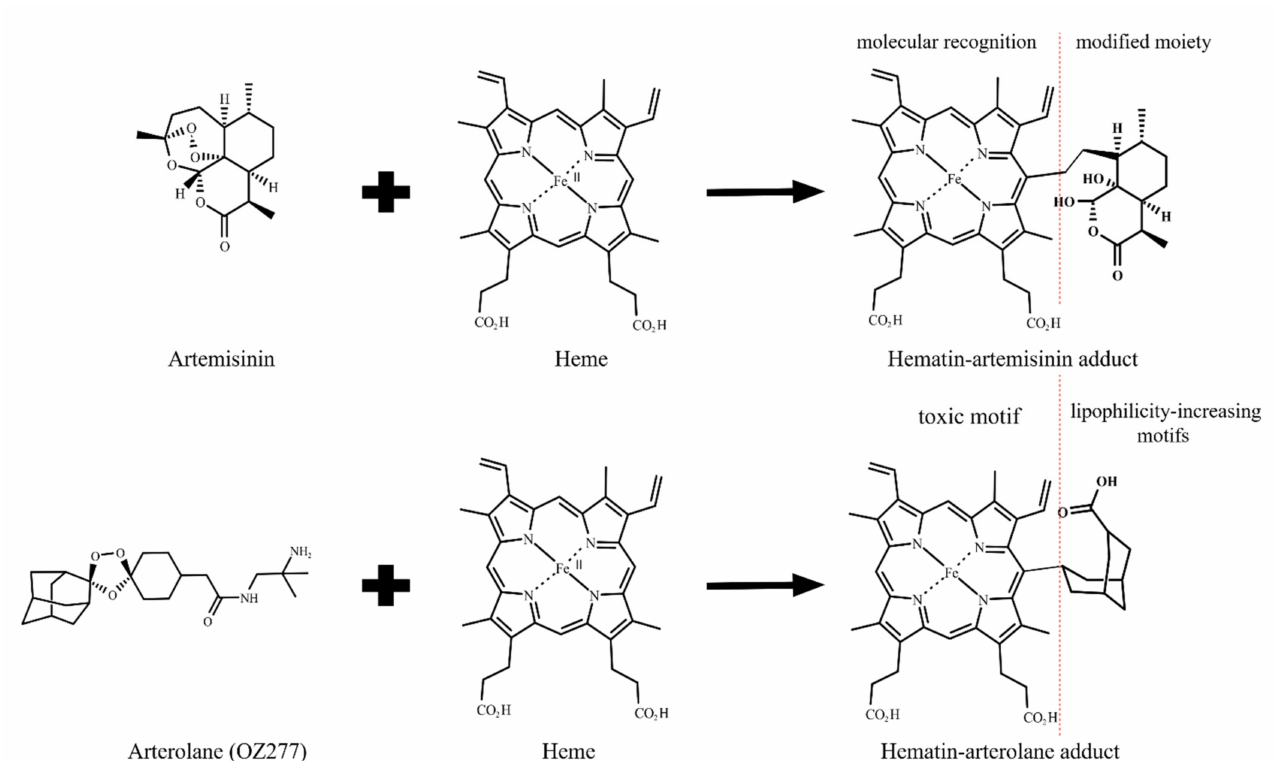
Figure 7. Formation of hematin–drug adducts from artemisinin and arterolane. Representation of the two possible pharmacophore domains: porphyrin and aliphatic groups. The adducts are embodied into the heme detoxification process by structural complementarity to porphyrin. However, the modified moieties impair a regular heme detoxification process, causing the suppression of heme detoxification. The modified moieties are aliphatic groups and are likely to be especially relevant for cell permeability and drug transportation for inside the